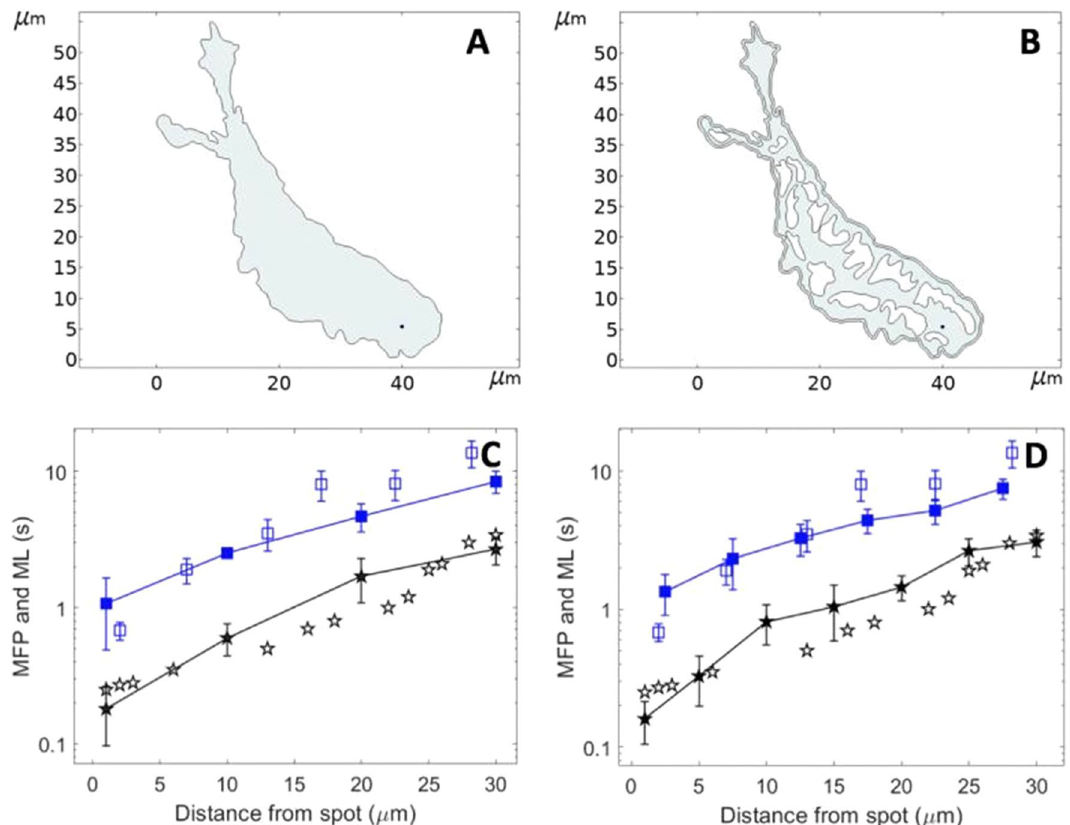
Figure 8. Theoretical investigation of the influence of the ER membranes on the diffusion of IP 3 and Ca 2+ puff occurrence. Panels ( A and B) show the 2D geometry considered in the computational simulations of IP 3 diffusion and Ca 2+ puff occurrence in response to the localized photorelease of a non-metabolizable IP 3 analogue. The shape of the cell was redrawn from Dickinson et al. (2016) and that of the ER was largely inspired from De Angelis et al. 39 . Panels ( C and D) show the simulated (plain symbols) and experimental (empty symbols) mean latencies (blue) and minimal first puff latencies (black). Flash duration is 500 ms. Simulation procedures are the same as for Fig. 4. The rates of localized IP 3 photorelease, θ, is taken equal to 400.6 μMs −1 and 284.65 μMs −1 , respectively which corresponds to the 250 μMs −1 used in the other simulations with